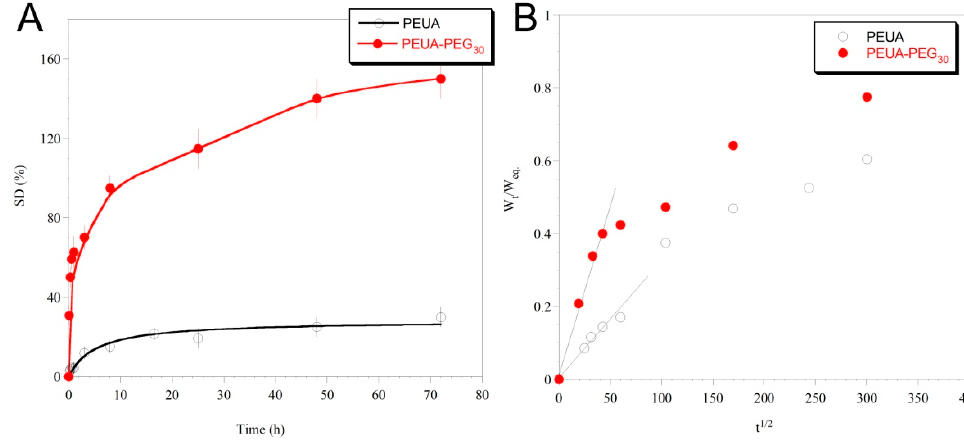
Figure 6. Swelling curves of PEUA and PEUA-PEG 30 ( A ); Ratio between the swollen polymer mass at time t , and at the equilibrium (W t /W eq ), as a function of the ratio of the square root of time ( B ). The diffusion coefficient was extrapolated by the slope of the linear fitting of the initial